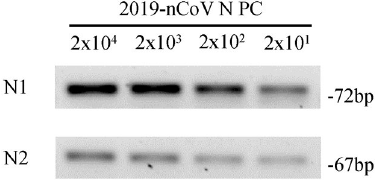
Figure 3. Analytical sensitivity for the two steps end point RT-PCR method for SARS-CoV-2 detection. RT-PCR and agarose gel (3%) electrophoresis for "2019-nCoV N PC" positive control for N1 and N2 amplicons at the detailed concentrations were replicated 5 times. Values correspond to viral loads in